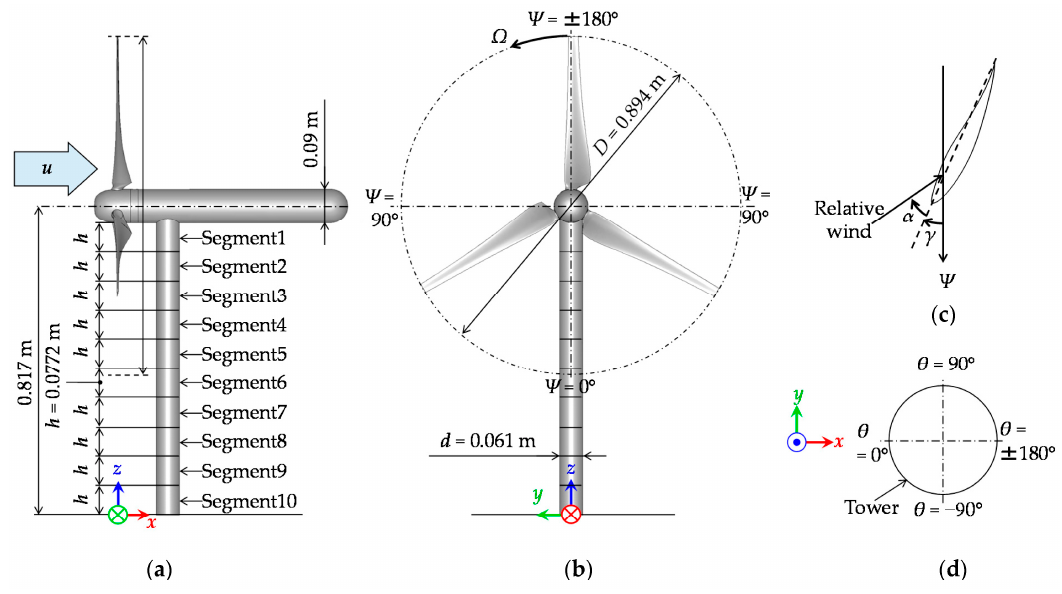
Figure 1. Geometry of the wind turbine and tower and the definitions of the angles Ψ , α , γ , and θ . ( a ) Side view of the wind turbine and tower; ( b ) front view of the wind turbine and tower; ( c ) cross-sectional view of the blade at Ψ = 0°; and ( d ) horizontal cross-sectional view of the tower.